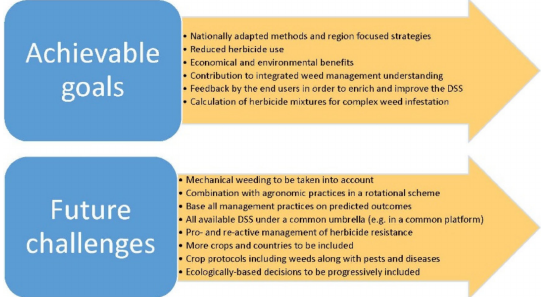
Figure 1. Indicative achievable goals and future challenges of weed-based decision support systems